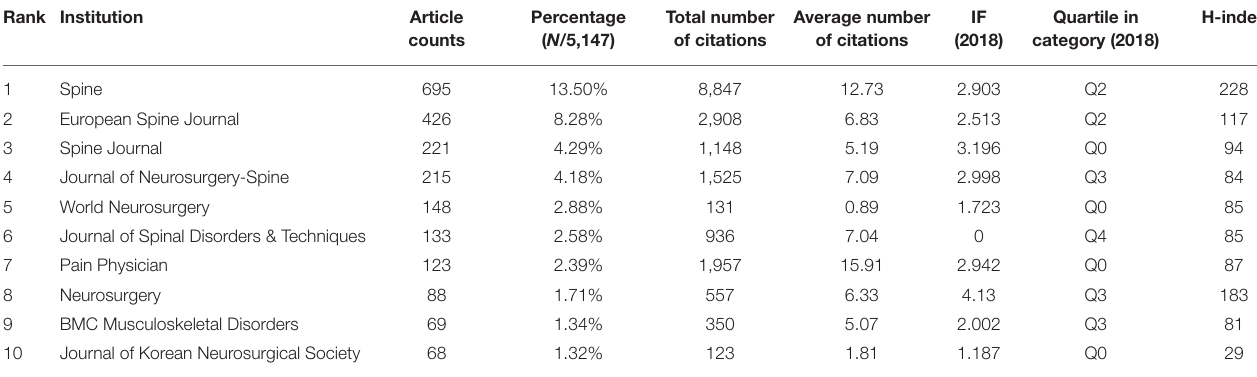
TABLE 4 | The top 10 journals contributing to publish articles in spinal stenosis